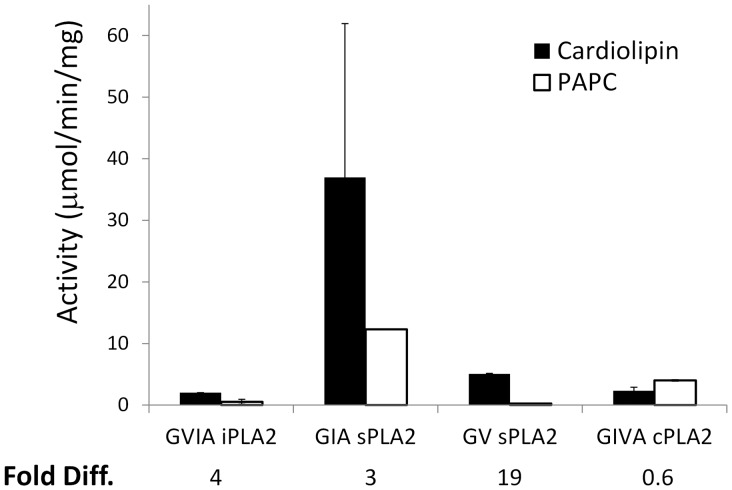
Comparison of PLA2 activities.The activities of GVIA iPLA2, GIA sPLA2, GV sPLA2, and GIVA cPLA2 toward cardiolipin (blue) and PAPC (red) are shown. The assays were conducted in mixed micelle assays containing either 100 µM cardiolipin or 100 µM PAPC and 400 µM Triton X-100. The fold differences between cardiolipin and PAPC were calculated and are shown.